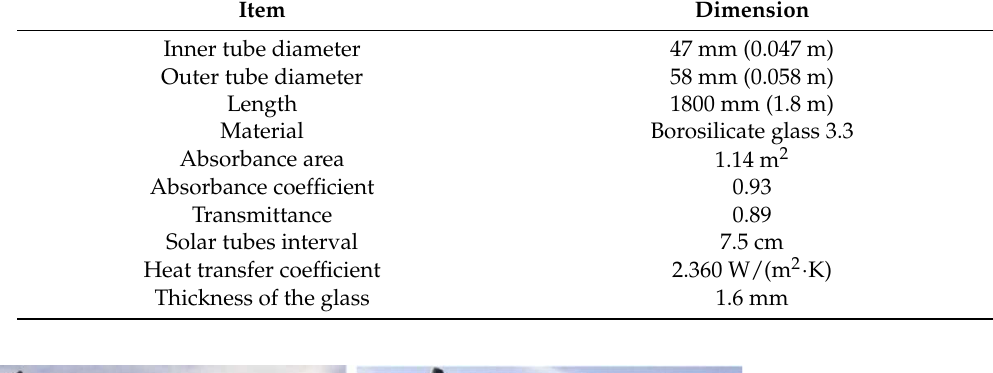
Table 1. Specifications of the experimental setup.